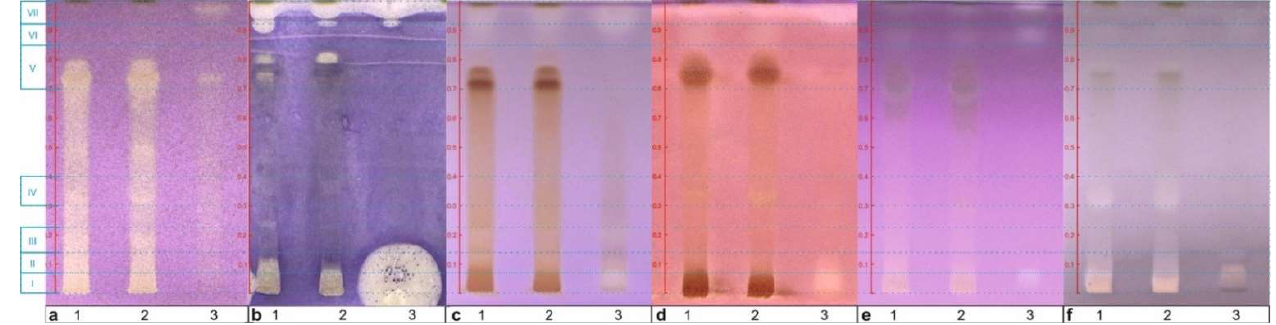
Figure 2. Bioautograms of the S. rubriflora extracts: (1) S. rubriflora M leaves; (2) S. rubriflora F leaves; (3) S. rubriflora fruits; ( a ) DPPH (VIS); ( b ) B. subtilis (VIS); ( c ) glucosidase inhibition (VIS); ( d ) AChE inhibition (VIS); ( e ) lipase inhibition (VIS); ( f ) tyrosinase inhibition (VIS). Mobile phase: F1; applied volume: 5 μL.